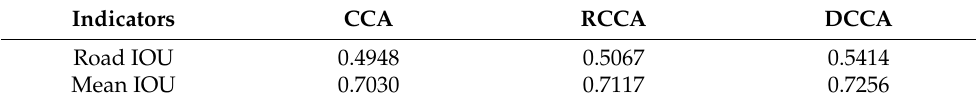
Table 4. The results of the different attention module on complete dataset.